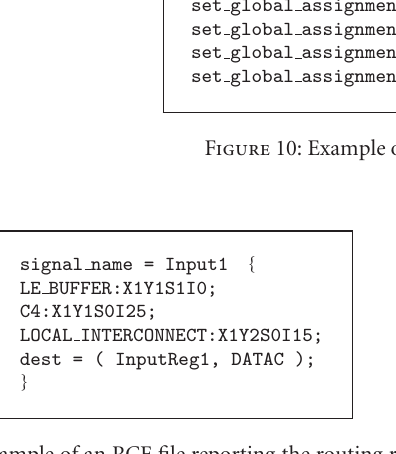
Figure 11: Example of an RCF file reporting the routing resources usage.